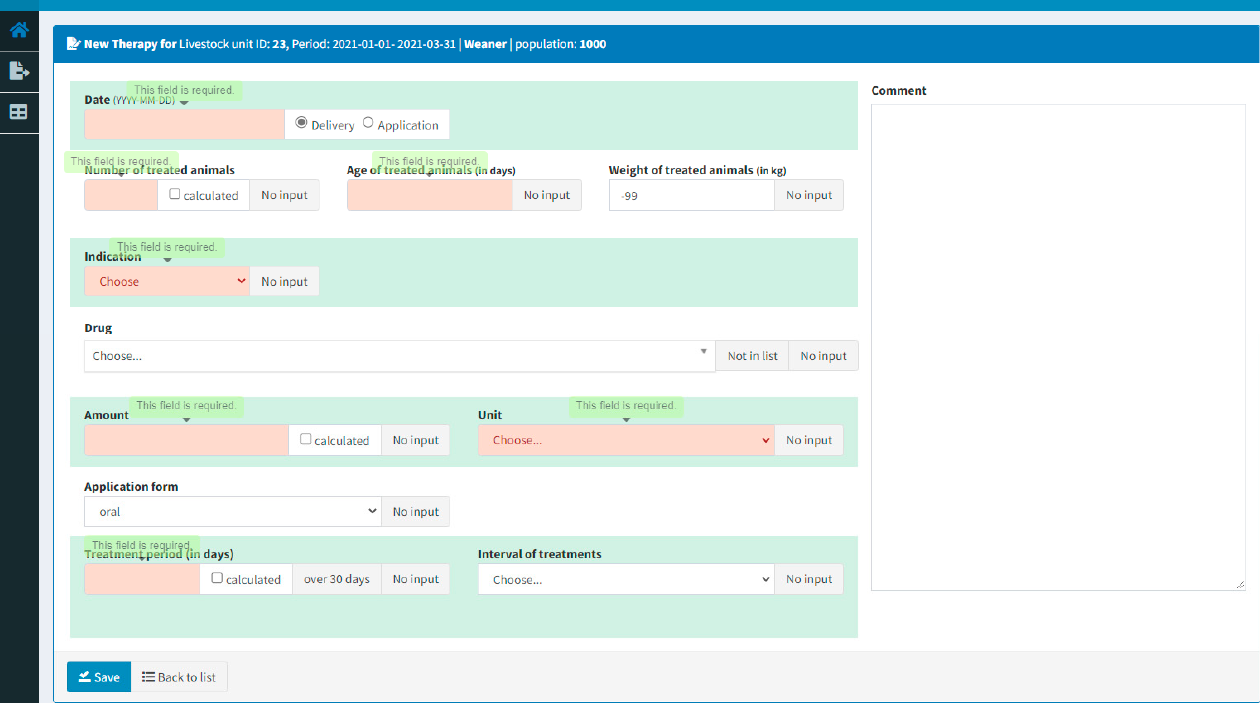
Figure 4. Form for entering therapies once livestock, period, kind of animal and population are registered. The picture shows an entry for a population of weaners from a test user.